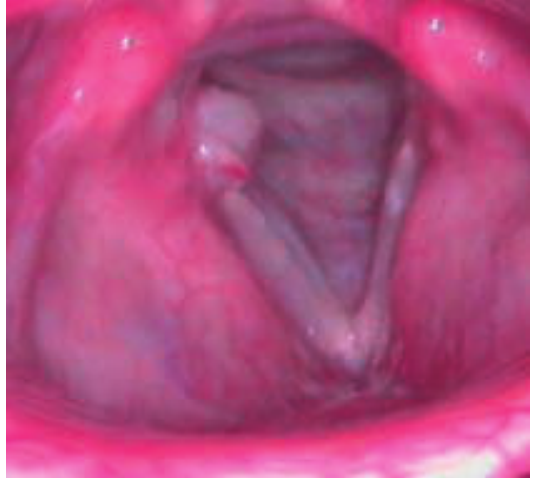
Figure 4 Contact granuloma at the processus vocalis of the right arytenoid